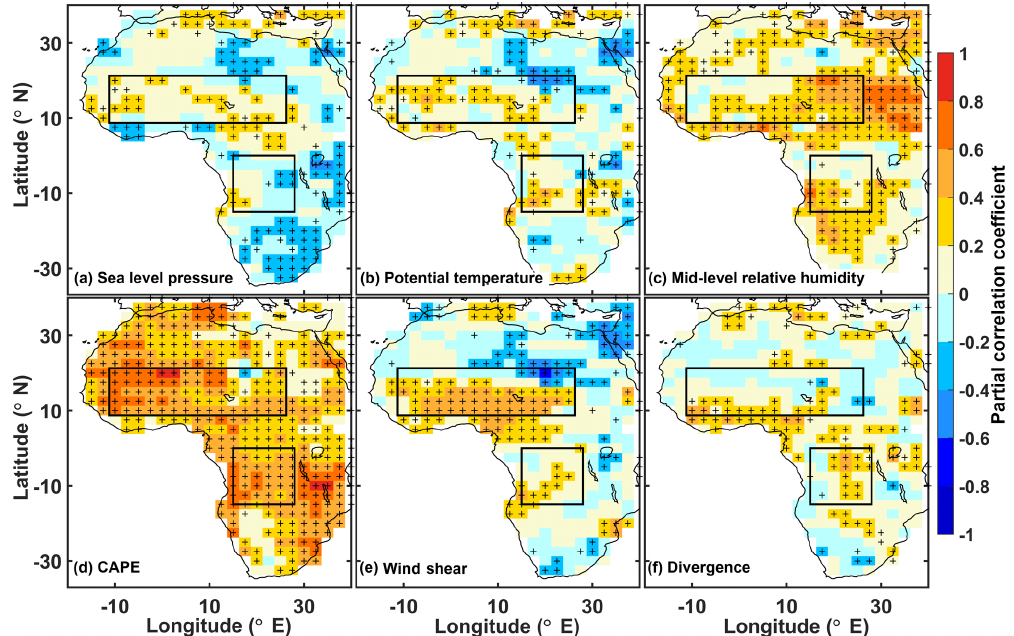
Figure 8. Same as in Fig. 7, but for the partial correlation